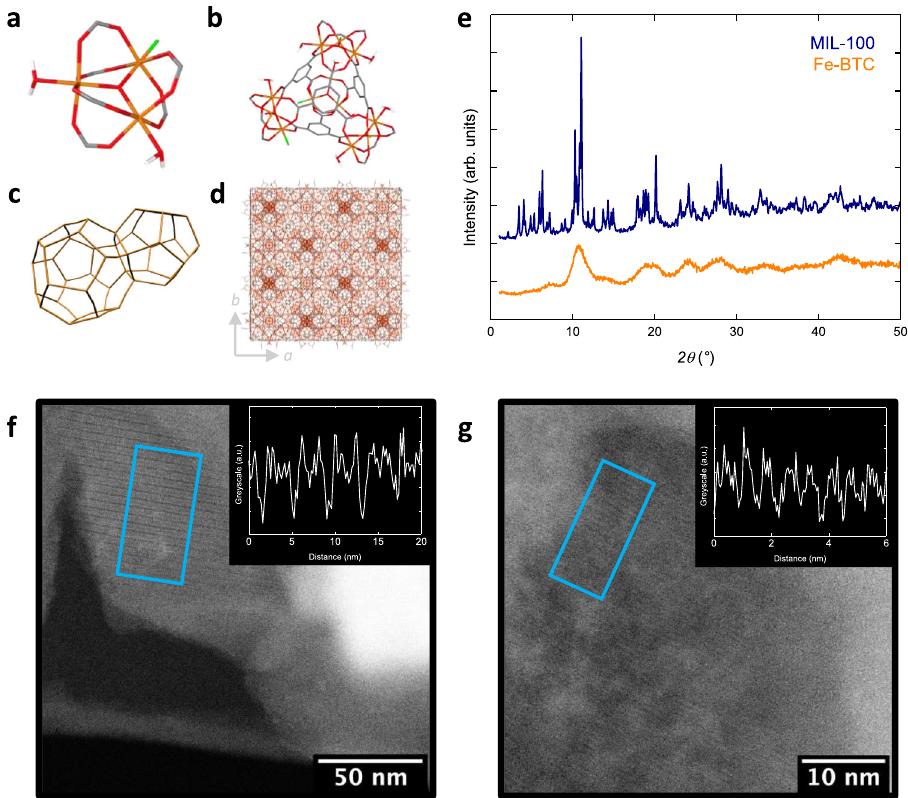
Fig. 1 Structural characterisation of MIL-100 and Fe-BTC. a Oxo-centred trimer unit (Fe orange, O red, C grey, F green and H from ligated water molecules white). b A tetrahedron assembled from four oxo-centred trimer units via the organic linker. c Dual pore structure of the mtn framework, tetrahedral units form the nodes of the connected network. Each vertex represents the centroid of a tetrahedron. d Crystallographic unit cell of MIL-100. e Powder X-ray diffraction data for MIL-100 (blue) and Fe-BTC (orange), data offset for clarity. f High-resolution scanning transmission electron micrograph of MIL-100. Lattice fringes corresponding to structural periodicity are highlighted in the blue box. The inset shows the corresponding line pro fi le of the lattice fringes highlighted. The distance between minima is 4.2 nm and corresponds to the (111) crystallographic planes of the MIL-100 structure. These features correspond to the Bragg re fl ections at 2.1° in ( e ). Data reproduced from ref. 34 . g High-resolution scanning transmission electron micrograph of Fe-BTC. Lattice fringes are highlighted in the blue box. The inset shows the corresponding line pro fi le of the lattice fringes highlighted. The distance between minima is 0.71 nm, consistent with a shorter degree of ordering compared to MIL-100. These features correspond to the scattering centred around 12.5° in ( e